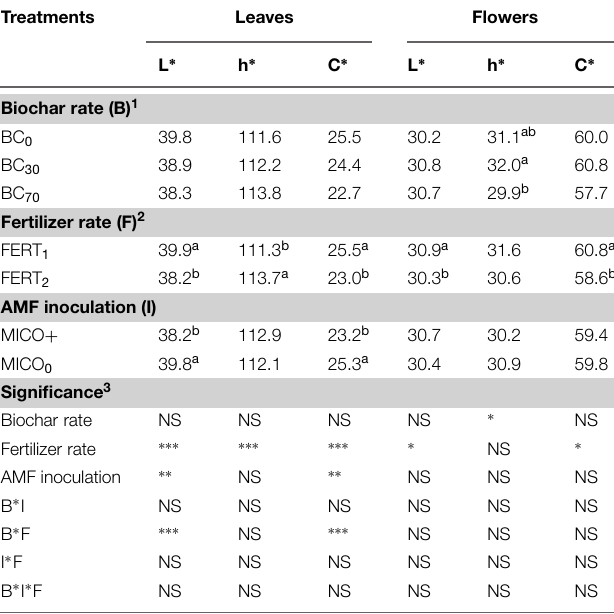
TABLE 6 | Color parameters of leaves and flowers of Pelargonium plants inoculated (MICO + ) or not (MICO 0 ) with AMF and grown for 74 d in substrate amended with different rates of biochar (BC 0 , BC 30 , BC 70 ), and fertilized with different rates of fertilizer (FERT 1 , FERT 2